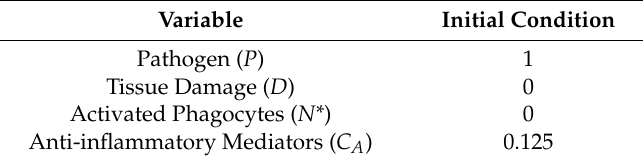
Table 2. Initial conditions corresponding to the healthy steady state in